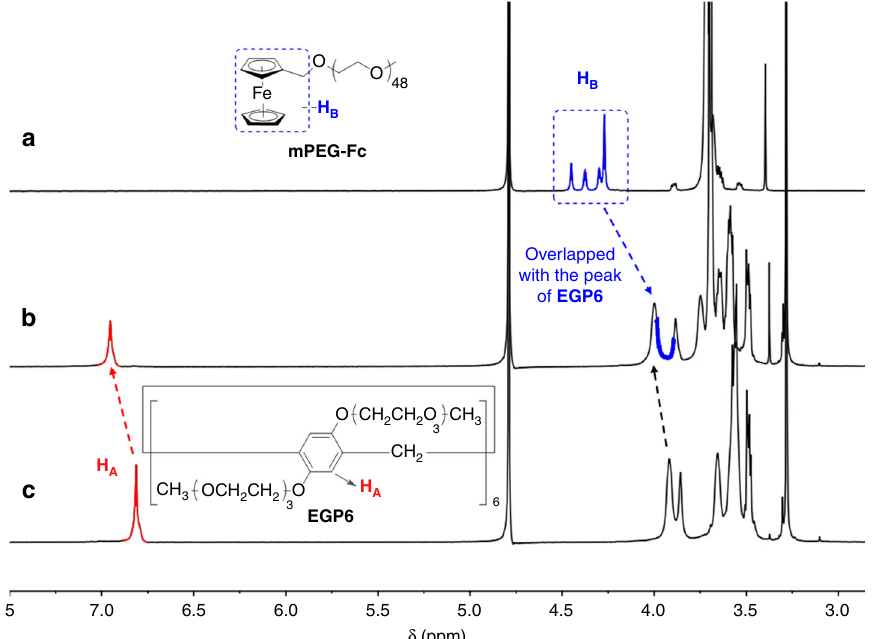
Fig. 2 Host – guest complexation investigated by 1 H NMR spectroscopy. Partial 1 H NMR spectra (400 MHz, D 2 O, 298K) of a 2 mM mPEG-Fc ; b 2 mM EGP6 and 2 mM mPEG-Fc ; c 2 mM